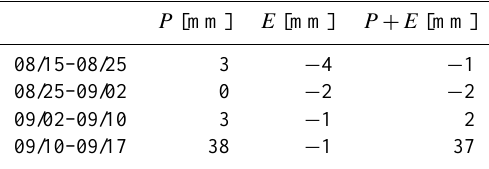
Total water gain (denoted positive) through precipita- tion P (measured at the village of Ny- ˚Alesund, www.eklima.no, 2010) and loss through evapotranspiration E (according to eddy co- variance measurements performed about 200m from the radar tran- sects, Westermann et al., 2009) between consectutive radar surveys. Values rounded to 1mm. Data on potential subsurface runoff are not